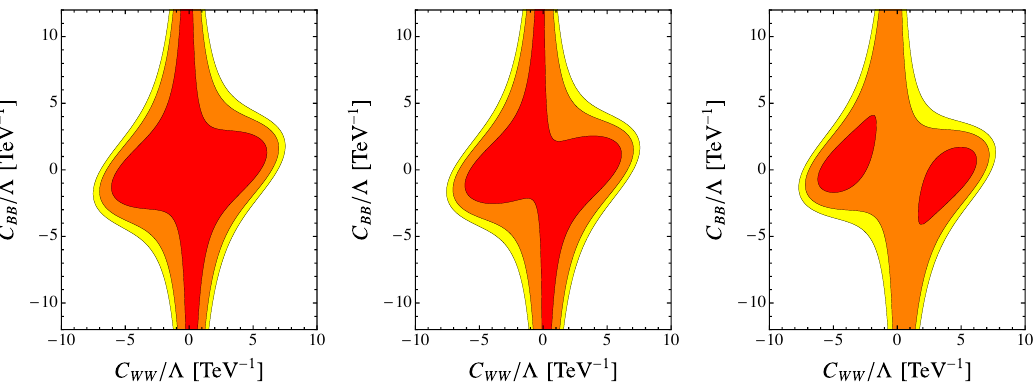
Figure 27 . Allowed regions in the parameters space of the Wilson coe(cid:14)cients C from a global three-parameter electroweak (cid:12)t [118] at 68% CL (red), 95% CL (orange) and 99% CL (yellow). The plots show projections onto the planes where C (5)